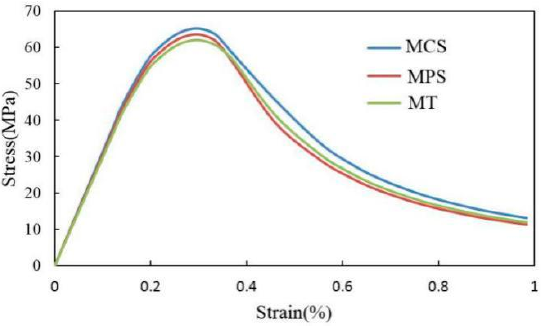
Figure 15. Uniaxial compression stress–strain curve of mortar (M1).